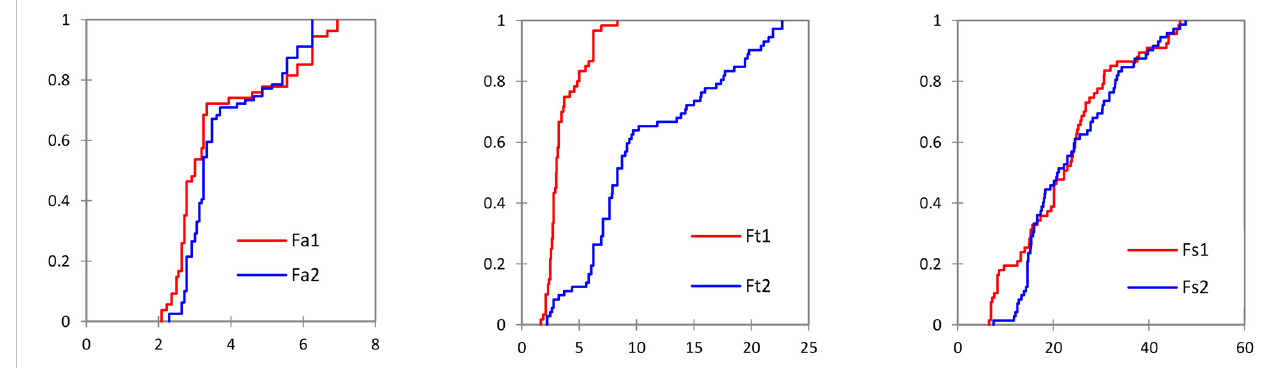
Figure 18. Comparative view of the NiTi-1 and NiTi-2 empirical CDFs in three seawater